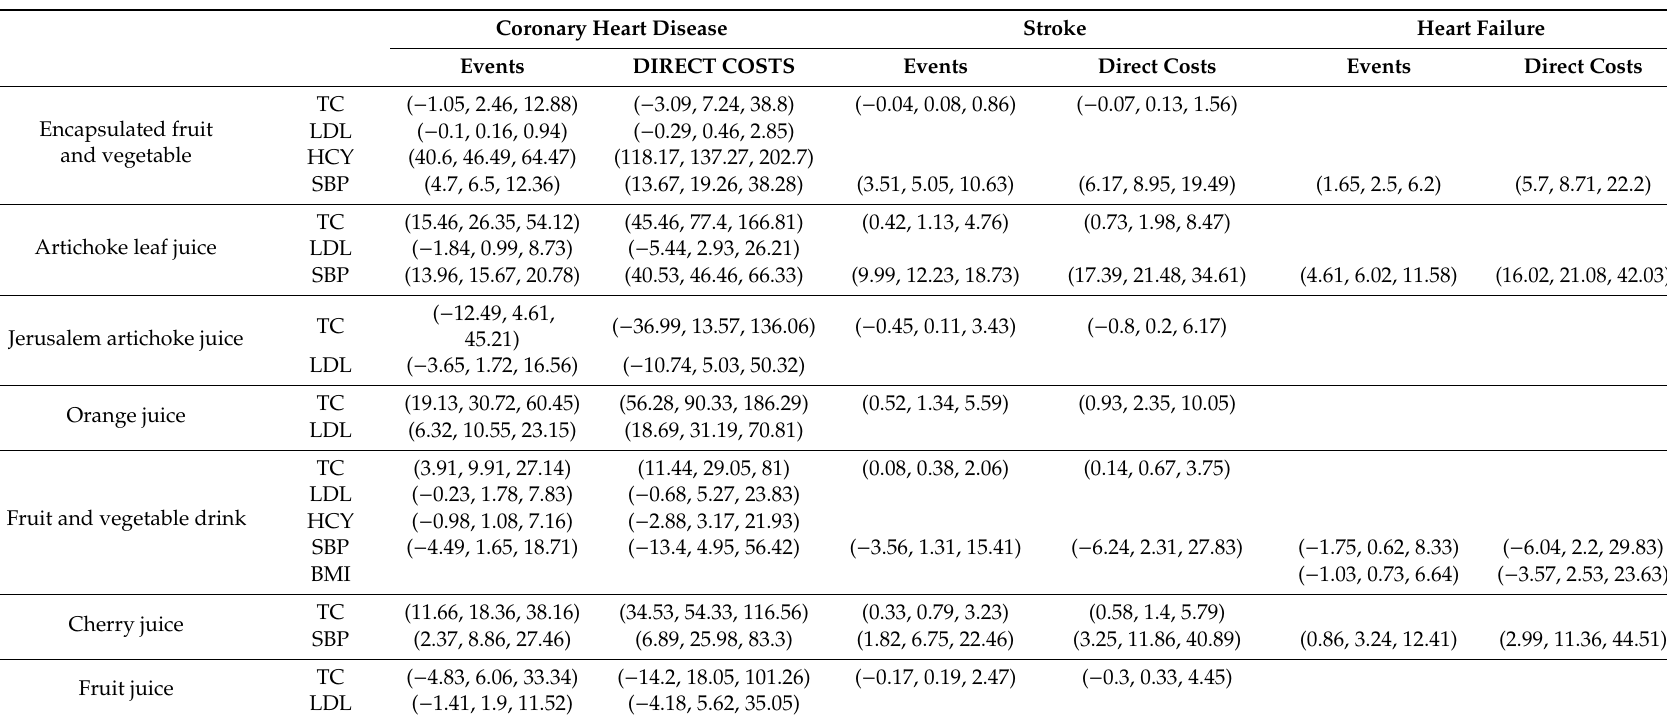
Table 5. Estimated e ff ect in terms of the absolute number of event reductions and their associated direct costs for di ff erent supplementation regimes in subjects with hypertension, projected in 2025. The median and the 95% credibility interval are reported. Reported events are expressed in millions of events (95% C.I. lower bound; median; 95% C.I. upper bound), while direct costs are expressed in billions of dollars (95% C.I. lower bound; median; 95% C.I. upper